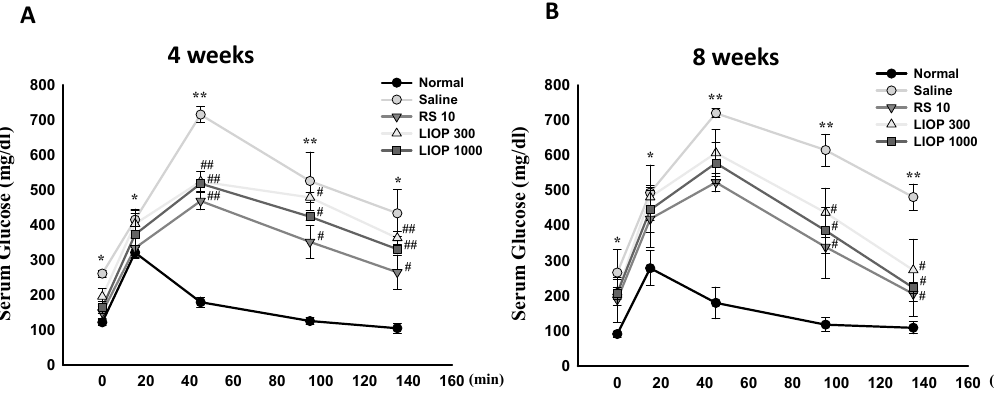
Figure 2. OGTT Patterns of LIOP. After an overnight fast, 3 g/kg of D -glucose was administered orally to C57BL/6 mice with HFD + STZ-induced diabetic nephropathy. The effects of LIOP (300 and 1000 mg/kg) and rosiglitazone (10 mg/kg) treatment were compared to the effects of the saline-only group at four ( A ) and eight weeks ( B ). The blood samples were taken at 0, 15, 45, 95, and 135 min after administration of D -glucose, and glucose levels were measured in whole venous blood with a glucometer (One Touch II, Lifescan). The data are expressed as mean ± SE of eight mice. *: p < 0.05, **: p < 0.001 compared to normal group. #: p < 0.05, ##: p < 0.001 compared to saline group. OGTT: oral glucose tolerance test; Normal: native control; Saline: vehicle control; RS: rosiglitazone; LIOP: Low-molecular-weight, 10–100 kDa polysaccharides from Inonotus obliquus extract.